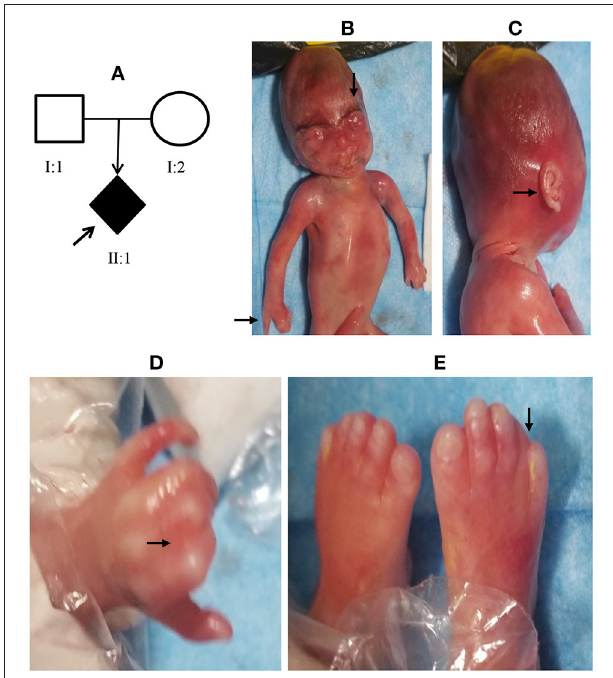
FIGURE 1 | Facial features and limb malformations of the fetus in case 1. A 28-year-old Chinese woman was referred for prenatal diagnosis at 16 weeks of gestation due to fetal nuchal translucency (NT) thickening (A) . The pregnancy was terminated at 20 weeks, and autopsy showed distinct facial features (B, C) and limb defects (B, D, and E) in the fetus as indicated by the